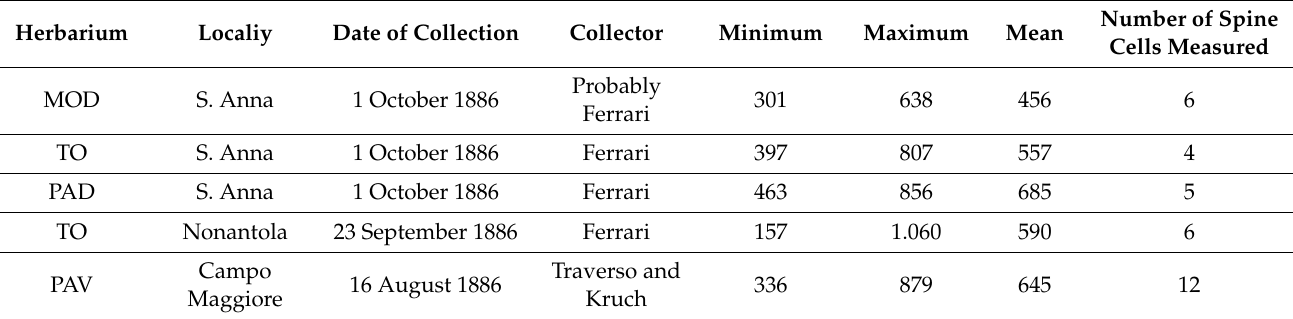
Table 5. Lengths of spine cells. All values are presented in µ